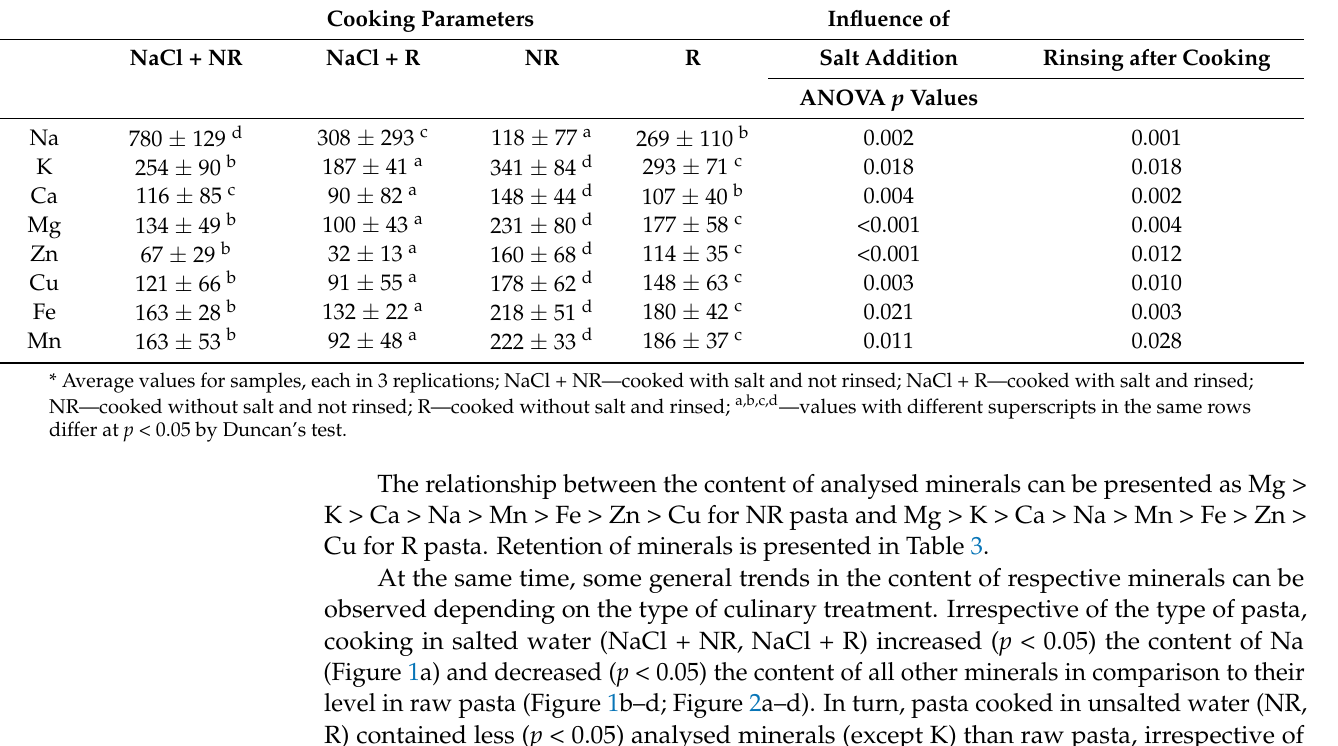
Table 3. The retention of Na, K, Ca, Mg, Zn, Cu, Fe, and Mn in products cooked with salt or without salt, and rinsed or not rinsed, % (percentage of mineral retention)